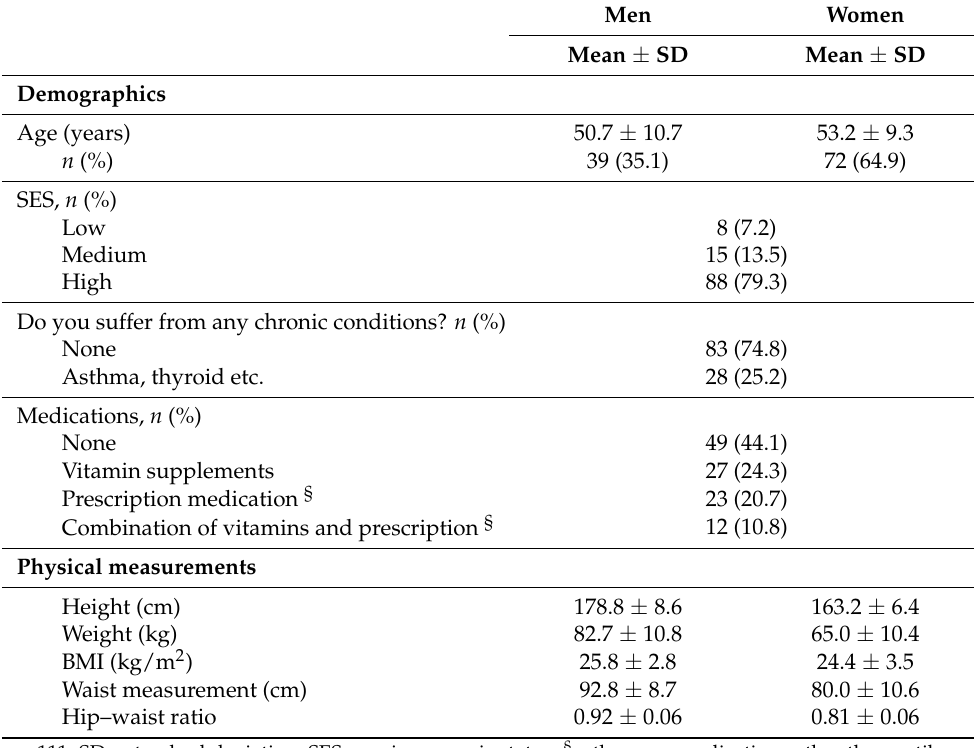
Table 1. Sociodemographic and physical profile of the study